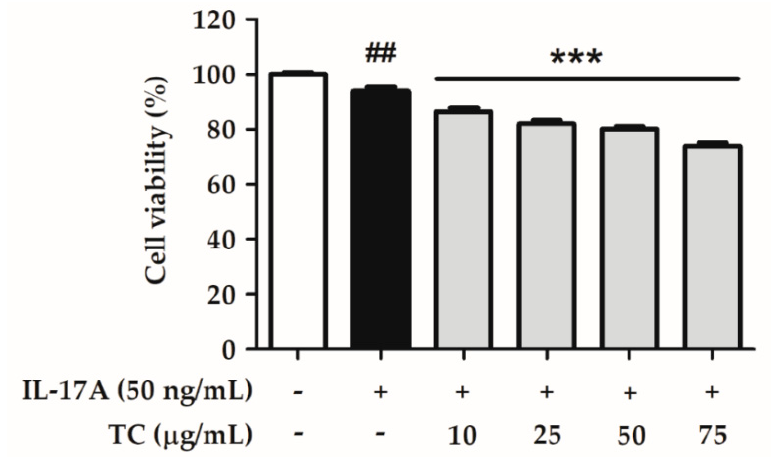
Figure 6. Effect of TC on cell viability in IL-17A-induced human keratinocytes. Significant differences between treated groups were evaluated. ## p < 0.01 compared to the control group. *** p < 0.001 compared to the IL-17A-induced group.